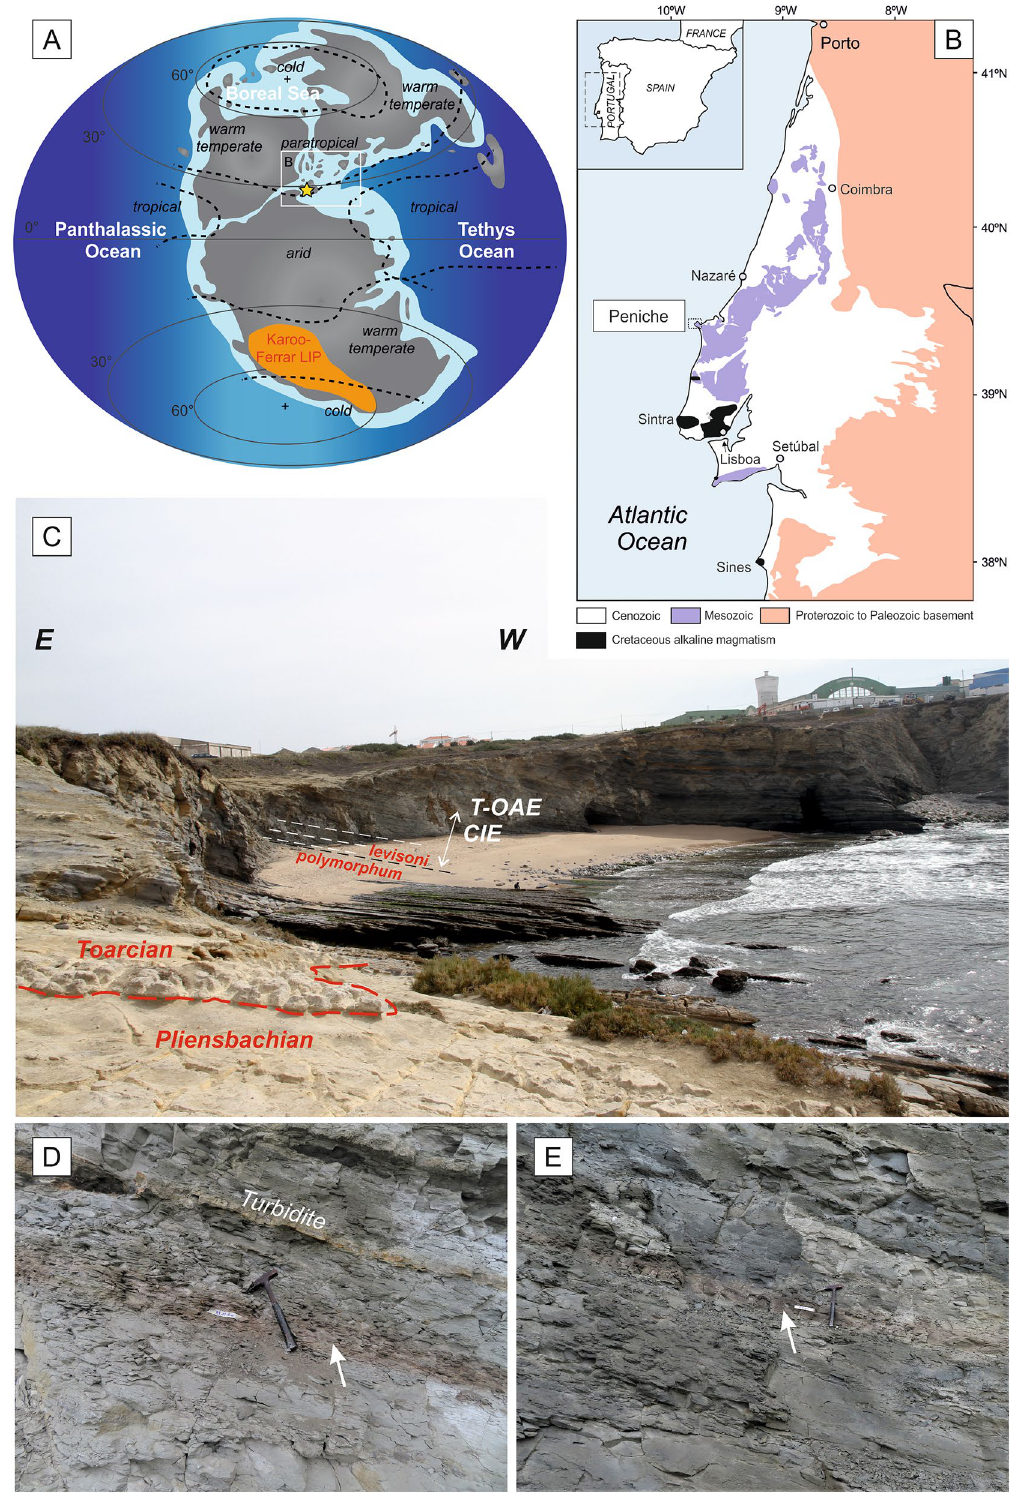
Figure 1. ( A ) Global Toarcian palaeogeographic reconstruction 90 with the location of the Karoo-Ferrar large igneous province in southern Gondwana, the position of palaeoclimatic belts after 102 , and the location of the Peniche section (yellow star). ( B ) Simplified geological map of the Lusitanian Basin, Portugal. ( C ) Field photographs of the Peniche section. The interval of the Carbon Isotope Excursion (CIE) of the Toarcian Ocean Anoxic Event (T-OAE) is indicated by the white arrow. White dashed lines indicate the position of the three brownish layers. ( D , E ) Field photographs of the second (labelled MC2 samples) ( D ) and third (labelled MC3 samples) brownish layers ( E